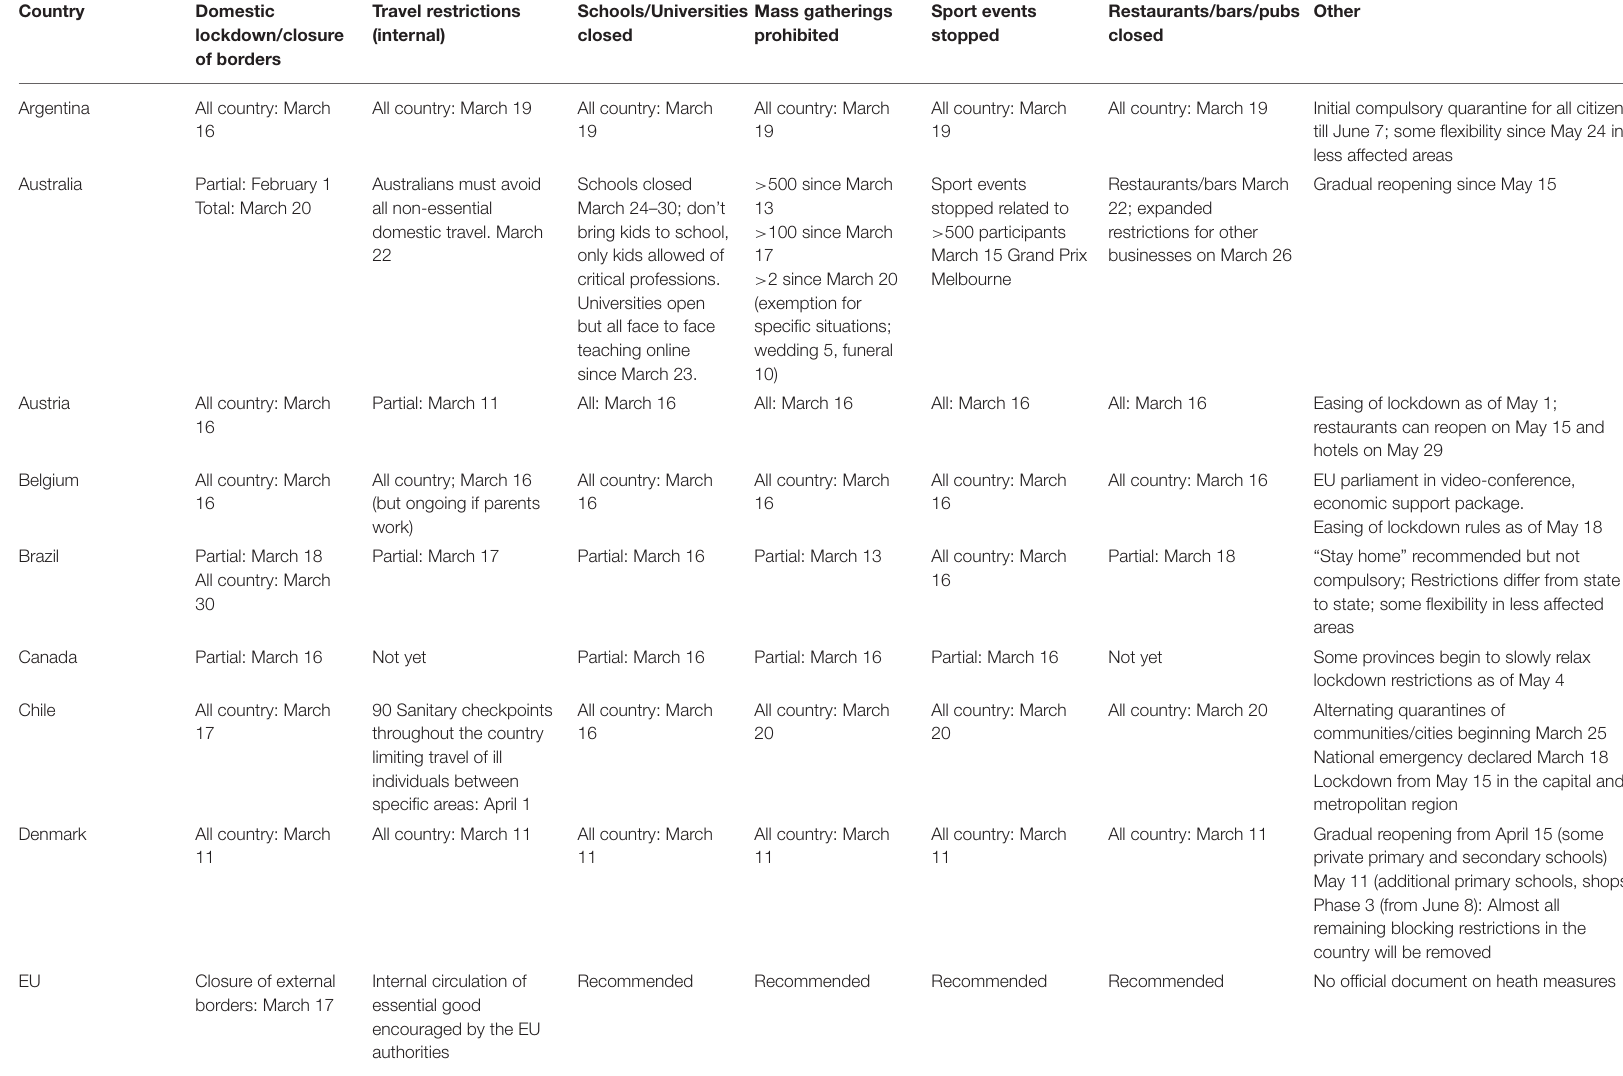
TABLE 1| Country specific non-pharmaceutical public health